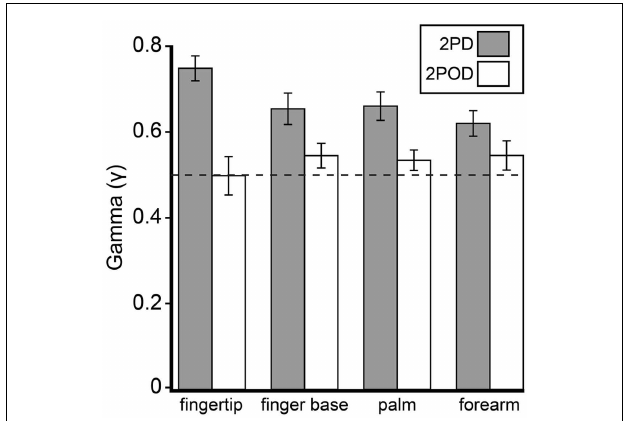
FIGURE 5 | Mean γ -parameters by task and body site . Gray bars, mean 2PD γ ; white bars, mean 2POD γ . Error bars: ± 1 SE. Dotted line: γ = 0.5.